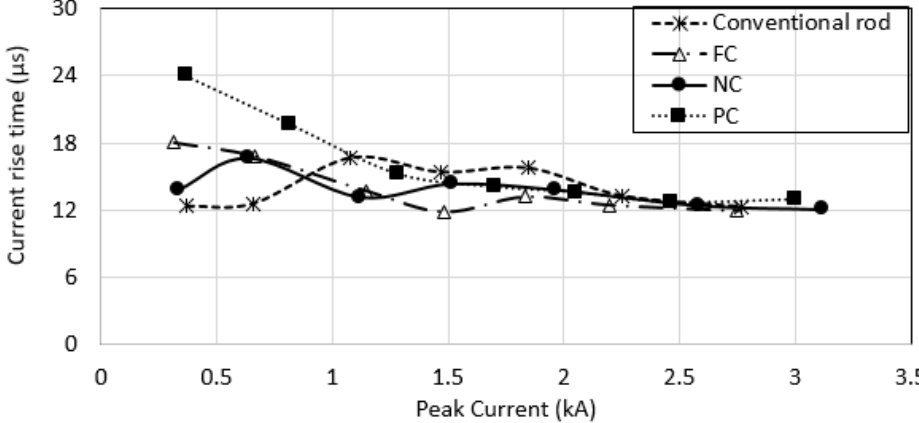
Figure 8. Current rise times for all tested electrodes vs. peak current .